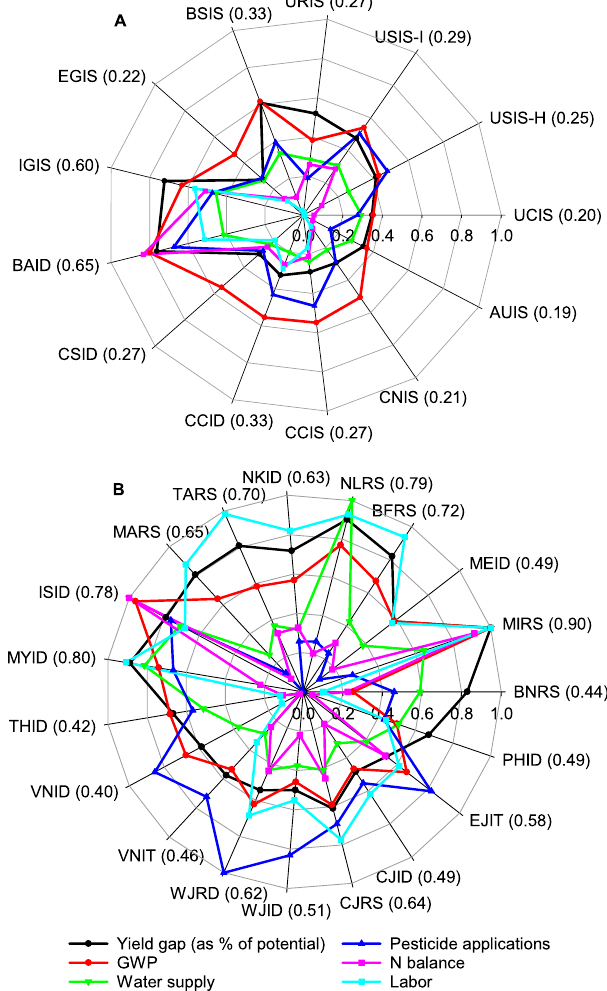
Fig. 5 Comparison of yield gap (as percentage of yield potential) and yield-scaled metrics including global warming potential (GWP), water supply, number of pesticide applications, nitrogen (N) balance, and labor across 32 rice cropping systems. Panels show radar charts for A non- tropical and B tropical regions. For each metric, data were normalized relative to the maximum value across all cropping systems, except for the yield-scaled N balance, which was expressed as an absolute deviation from 8 kg N Mg − 1 grain. Parenthetic values are the performance index of each system, with lower (higher) values indicating better (worse) overall performance. Cropping system codes are shown in caption to Fig. 1. See “ Methods ” section for explanation about the calculation of the overall performance index. Data are provided in Source